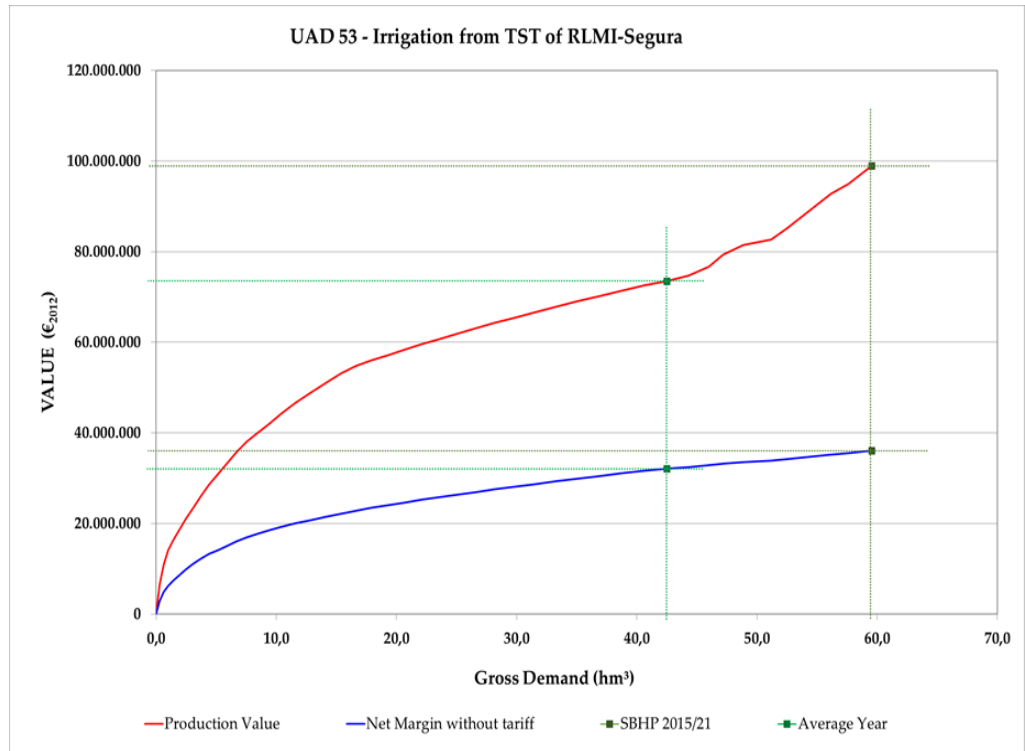
Figure 5. Demand curve, production value and net margin in UAD 53, SBHP 2015/21 and average year. Source: SBHP 2015/21.